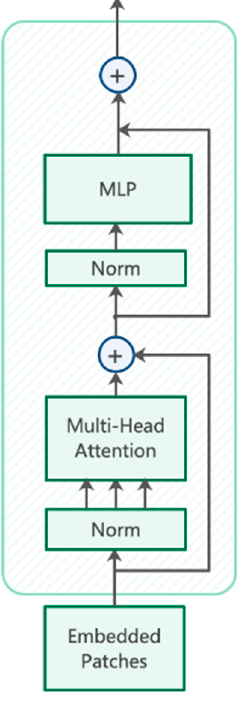
Figure 3. The architecture of TRANS encoder.